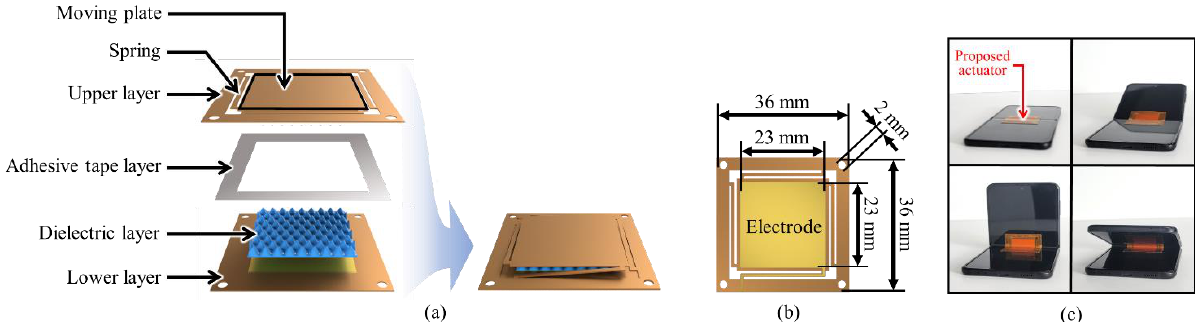
Figure 1. Proposed flexible vibrotactile actuator based on dielectric elastomer: ( a ) overall structure of the proposed actuator and assembled vibrotactile actuator; ( b ) bottom surface of the upper layer; ( c ) proposed actuator attached to a foldable smartphone.